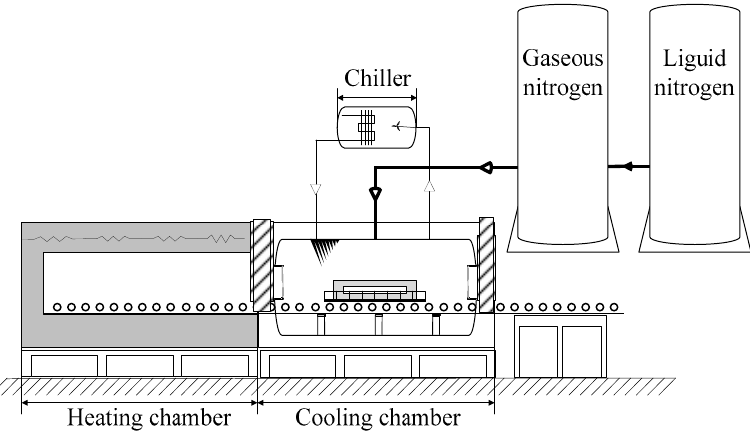
Figure 2. Schematic drawing of the proposed nitrogen cooling system.